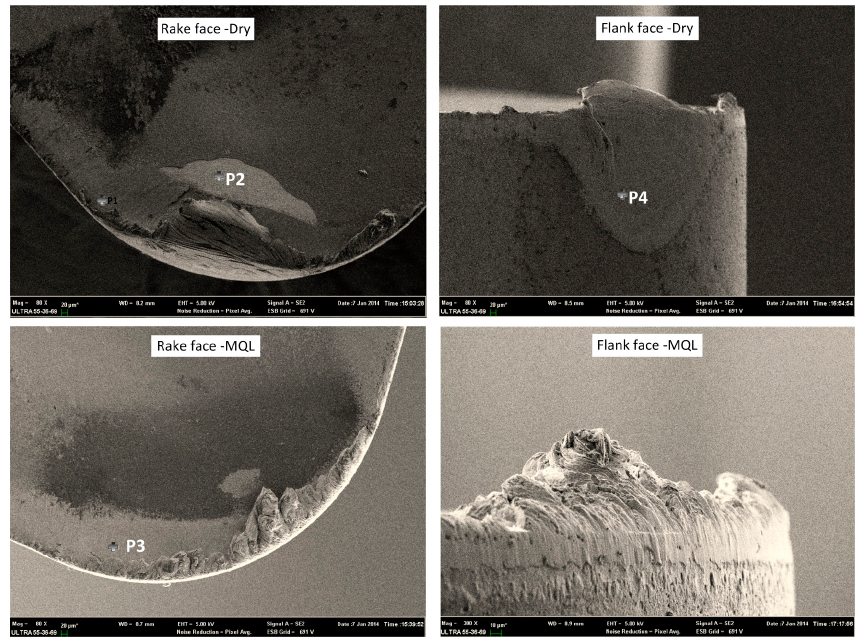
Figure 7. SEM and EDS results of Al 2 O 3 /TiAlN-coated insert under dry and MQL conditions. Table 5. EDS analysis of the wear region of Al 2 O 3 /TiAlN-coated insert (wt. %, check points refer to Figure 6). Point